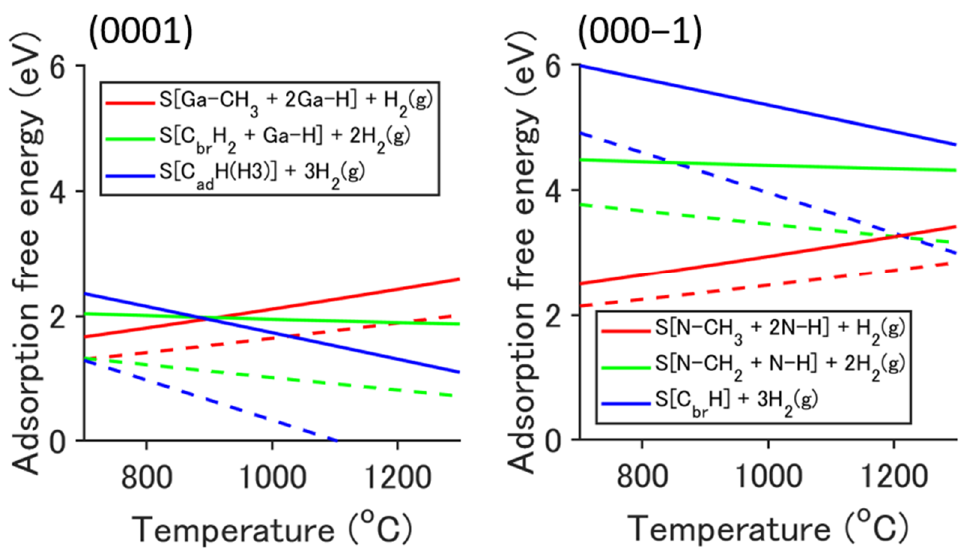
Figure 3. Adsorption free energy of CH 4 onto the 3Ga-H and 3N-H (2 × 2) surfaces. The red, green, and blue lines correspond to Stage-1, Stage-2, and Stage-3 in Figure 2, respectively. The growth conditions are p CH4 = 3 p Ga = 7.5 × 10 −4 atm, p H2 = 0.7 atm (solid lines), and p H2 = 0.01 atm (dashed lines).